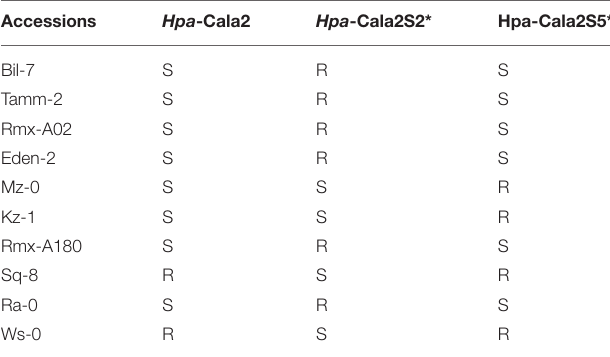
TABLE 1 | Interaction phenotypes of Arabidopsis accessions with the parent isolate Hpa -Cala2 and two offspring.